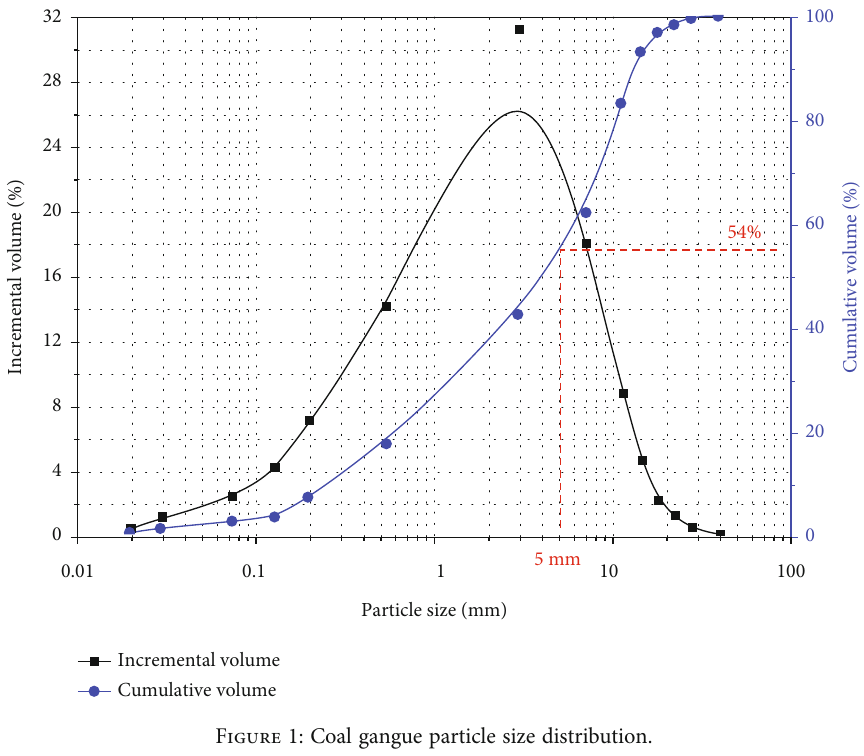
Figure 1: Coal gangue particle size distribution.